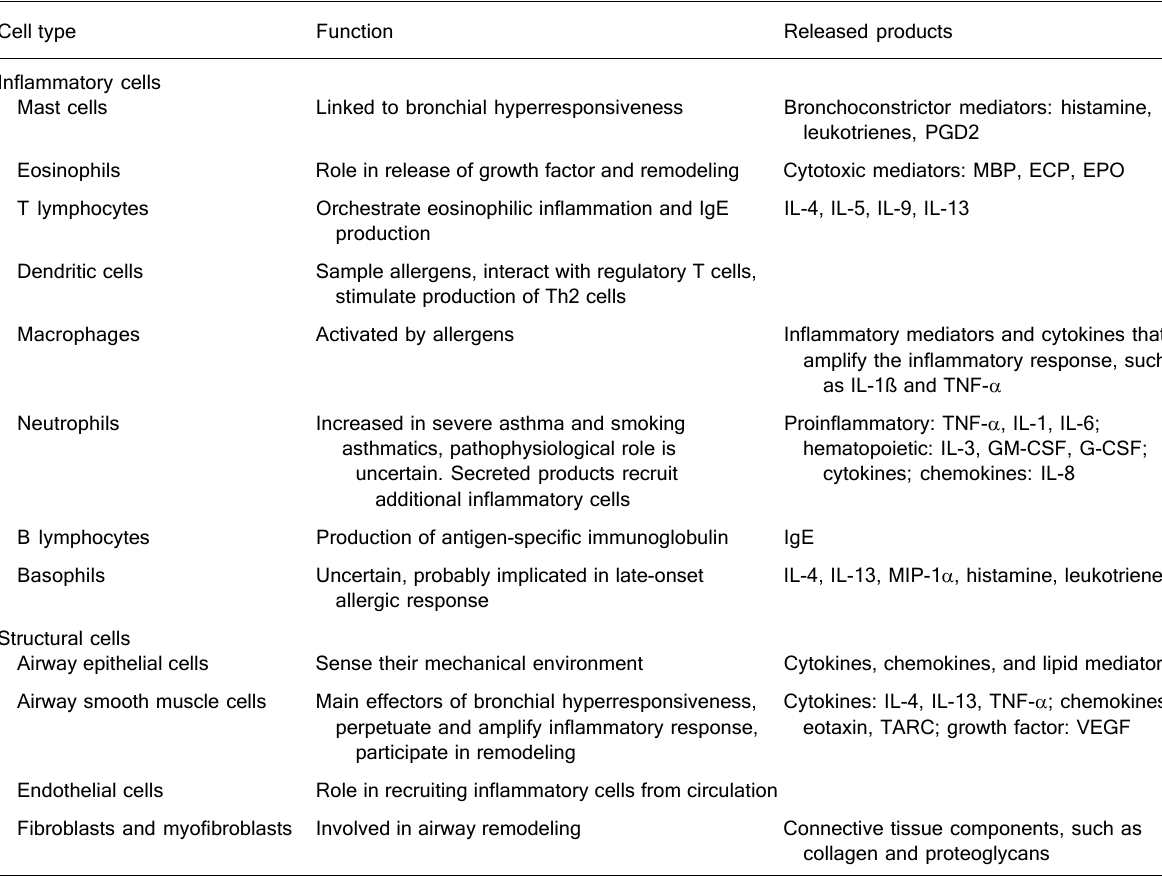
Table 1. Cells involved in the pathogenesis of